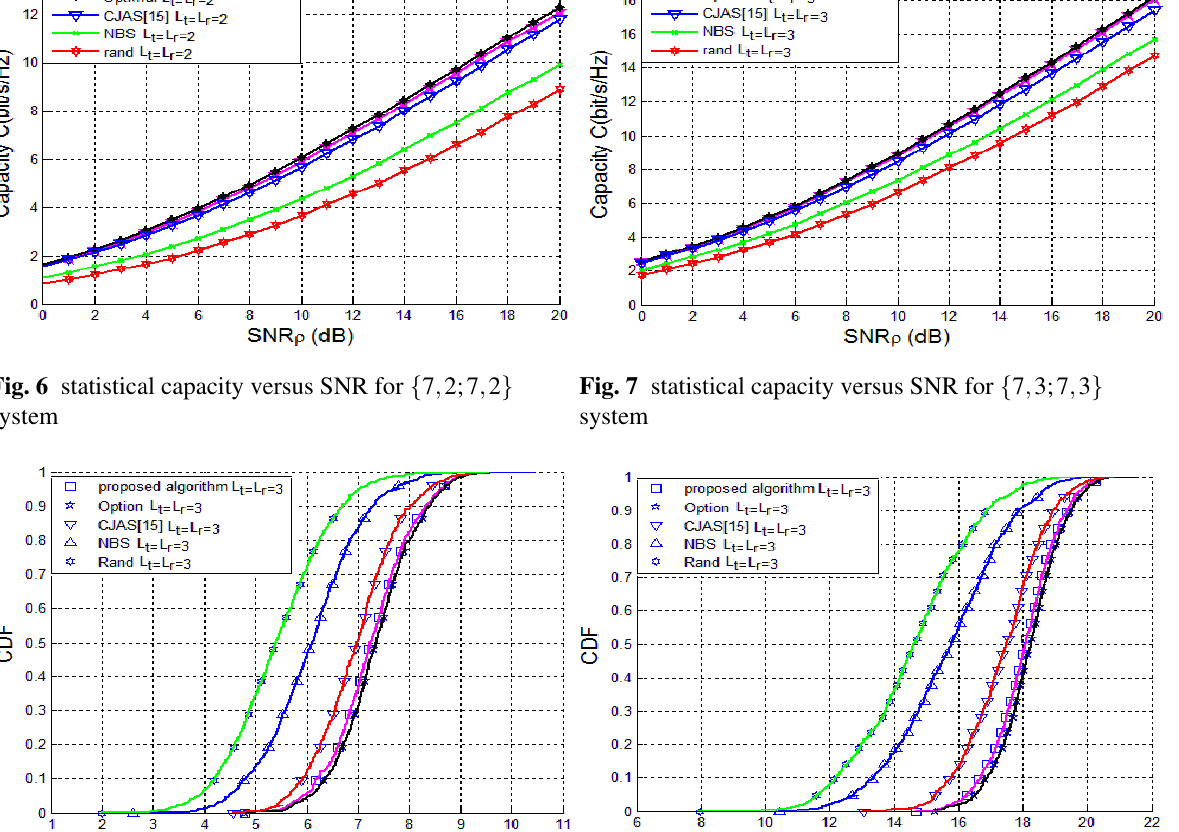
Fig. 8 the curves of capacity CDF for { 5 , 3;5 , 3 } system, SNR=8dB